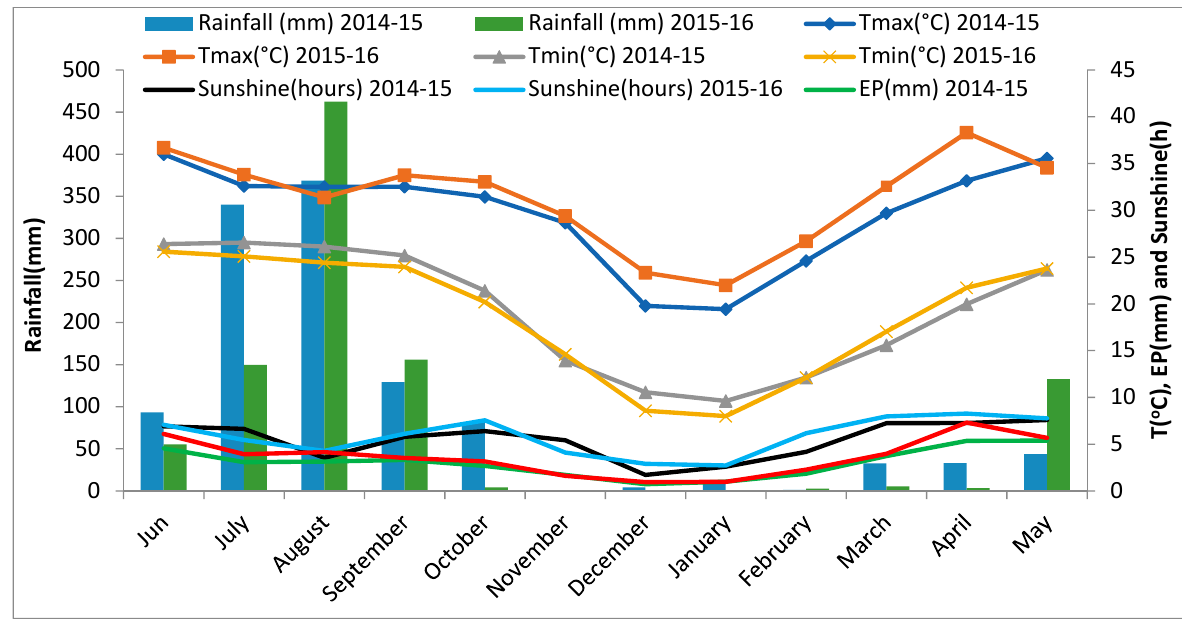
Figure 1. Monthly mean minimum and maximum temperatures (°C), total rainfall (mm), pan evaporation (EP, mm), and sunshine hours for the cropping calendars 2014–2015 and 2015–2016.